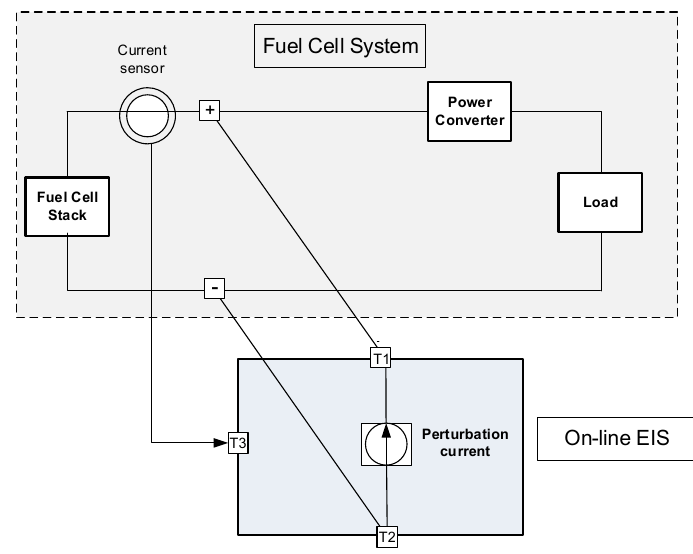
Figure 2. Configuration of proposed on-line EIS .